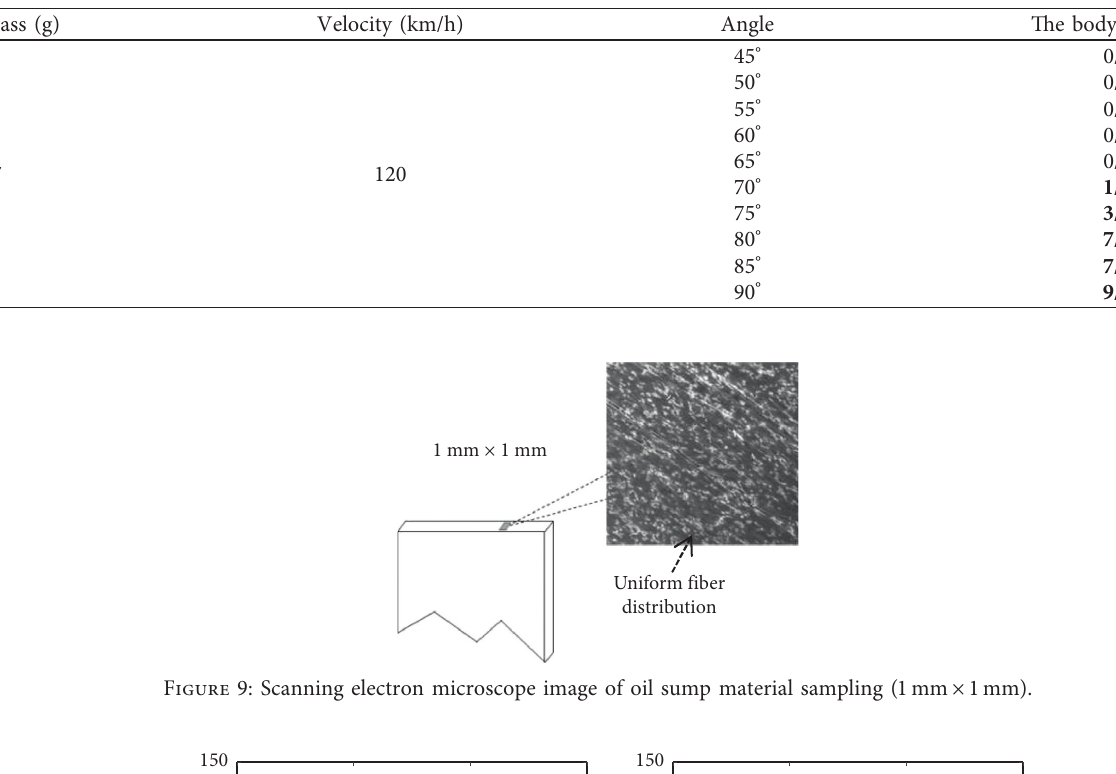
Table 5: Test results IV.